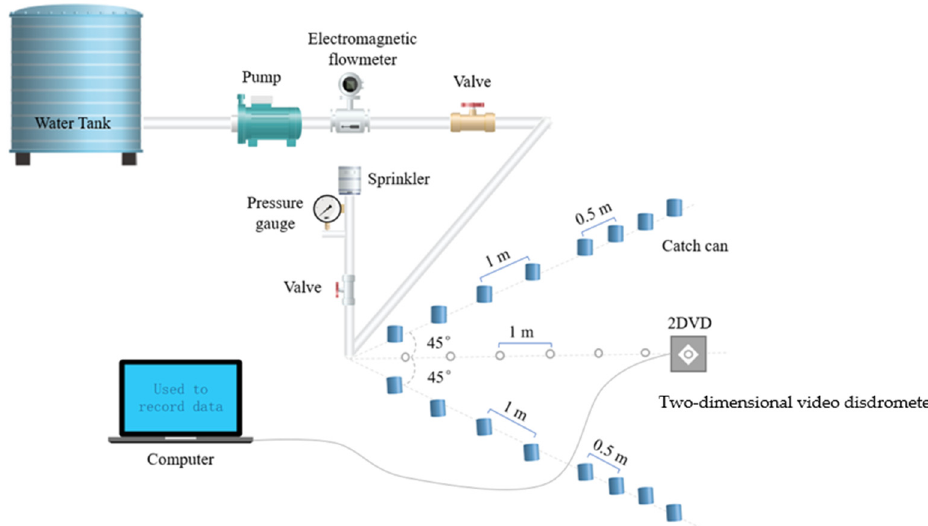
Figure 2. Layout of the experimental system.